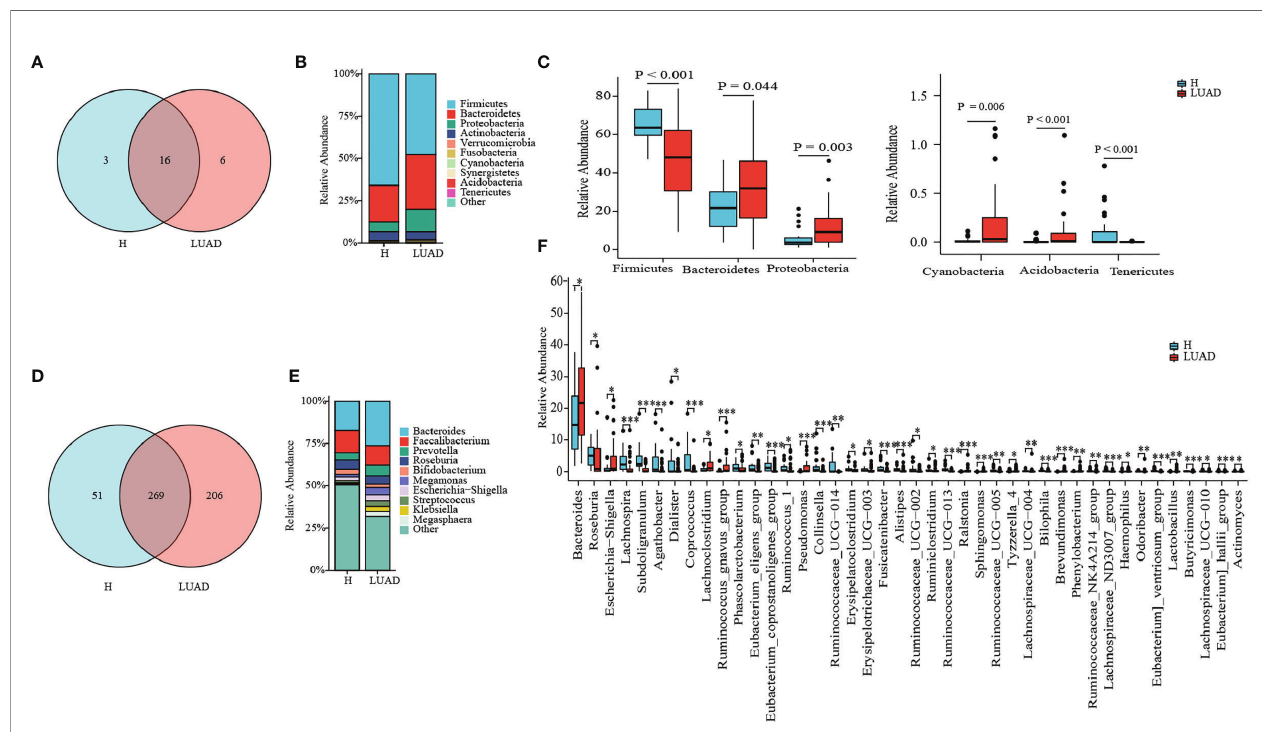
FIGURE 2 | Taxonomy comparison of gut microbiome. (A) 19 and 22 phyla were identi fi ed in H group and LUAD group, respectively. (B) The distribution of top 10 phyla in two groups. (C) Differential phyla between two groups. (D) 320 and 475 genera were identi fi ed in H group and LUAD group, respectively. (E) The distribution of the top 10 genera in two groups. (F) Differential genera between two groups. *P < 0.05, **P < 0.01, ***P <